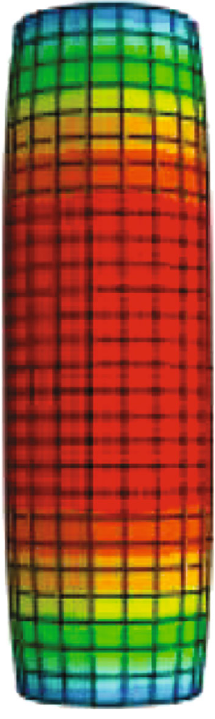
Figure 10: Nephogram of fi nite element calculation.